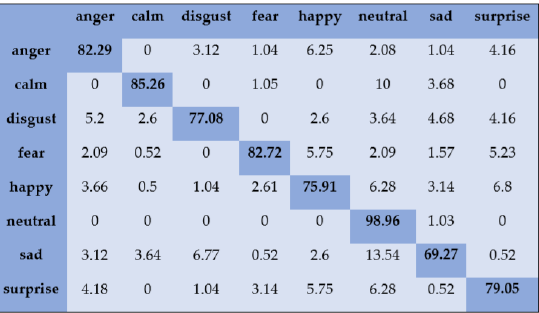
Figure 4. Confusion matrix of RAVDESS dataset for speaker-dependent SER.